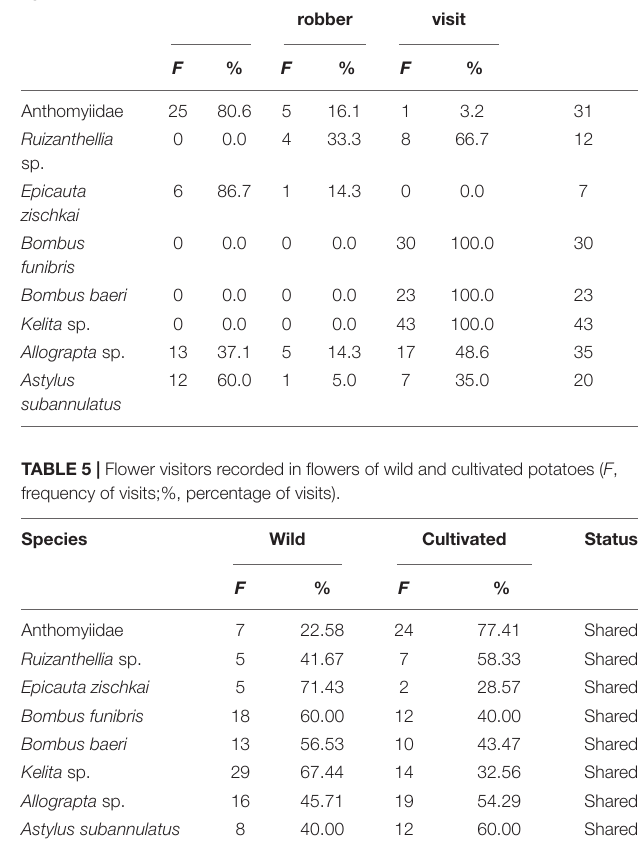
TABLE 4 | Foraging behavior of the flower visitors identified ( F , frequency of TABLE 7 | Duration of visits (in seconds) of the species of insects visiting flowers visits;%, percentage of visits). of the potato species and varieties studied. Species Visitor Pollen Effective Total of visits robber